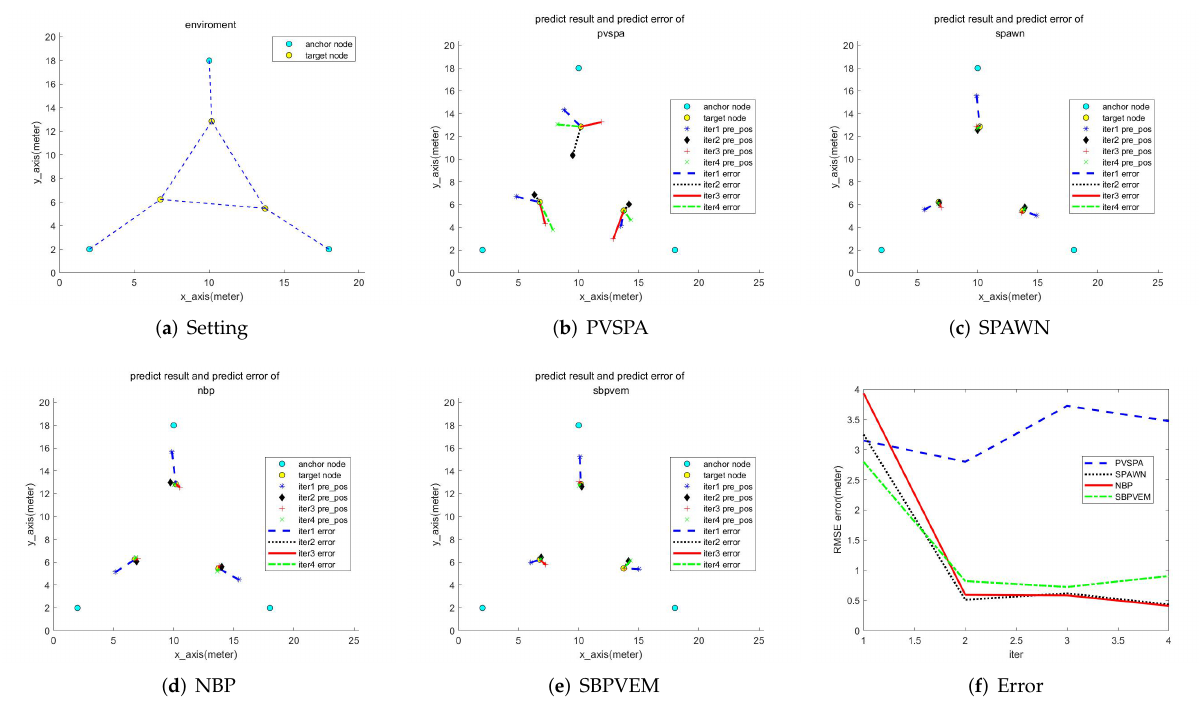
Figure 5. Location results of connection scenario 2. ( a ) exhibits the setting of scenario 2. Anchors are represented by cyan nodes, whereas yellow nodes represent targets. Blue dotted lines link two nodes with communication. PVSPA, SPAWN, NBP, and SBPVEM iterative positioning results and corresponding positioning errors are shown in ( b – e ). ( f ) comparing the prediction errors of various algorithms in the iterative